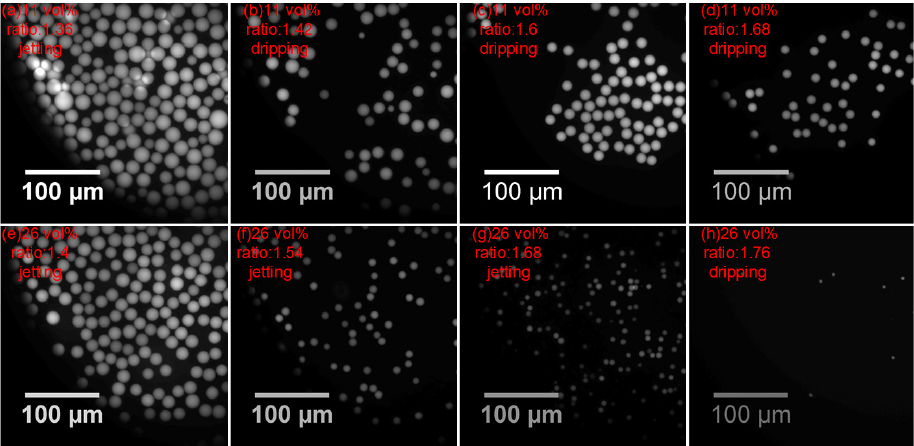
Figure 10. Droplet generate under different states. The CVs of ( b ) and ( g ) are difficult to